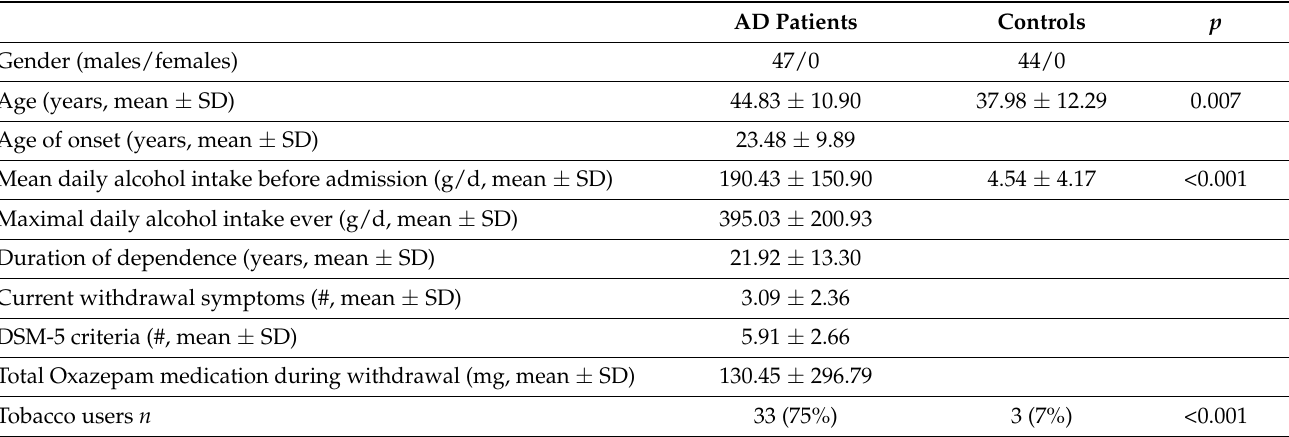
Table 1. Demographic Variables and Clinical Characteristics of Alcohol- Dependent Individuals and Healthy Controls. AD